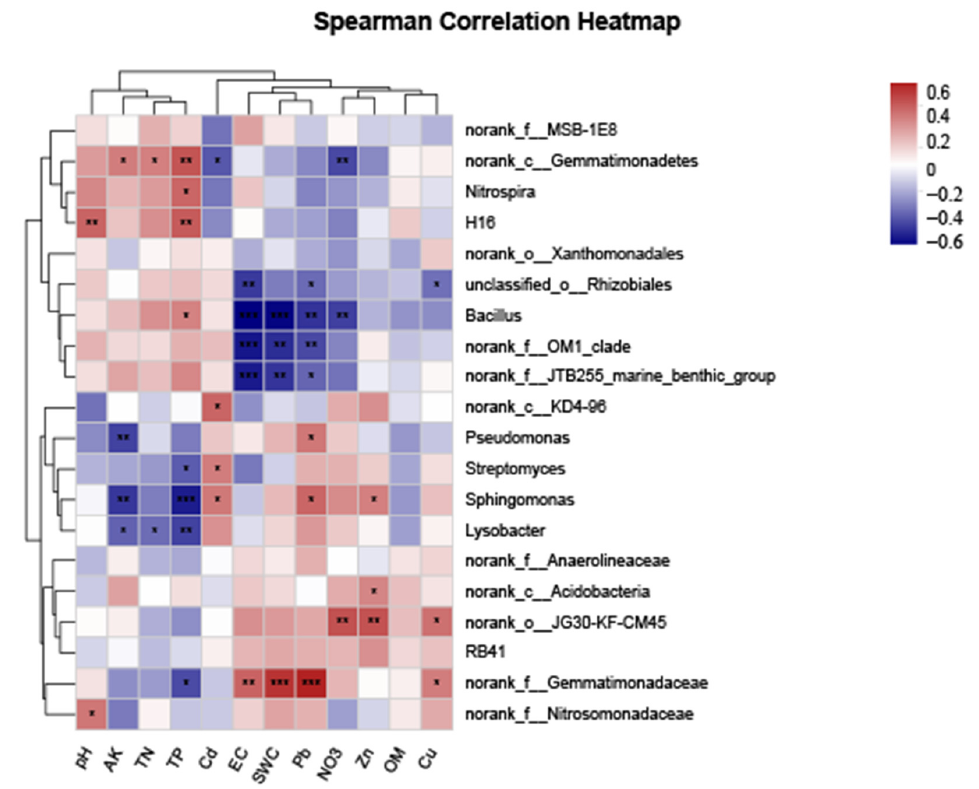
Figure 4. The heatmap analysis between soil environmental factors and the relative abundance of soil microbes (genus level) under different irrigation treatments. The correlation analysis was Spearman correlation. * means the correlation is significant at 0.05 level. ** means the correlation is significant at 0.01 level. *** means the correlation is significant at 0.001 level.